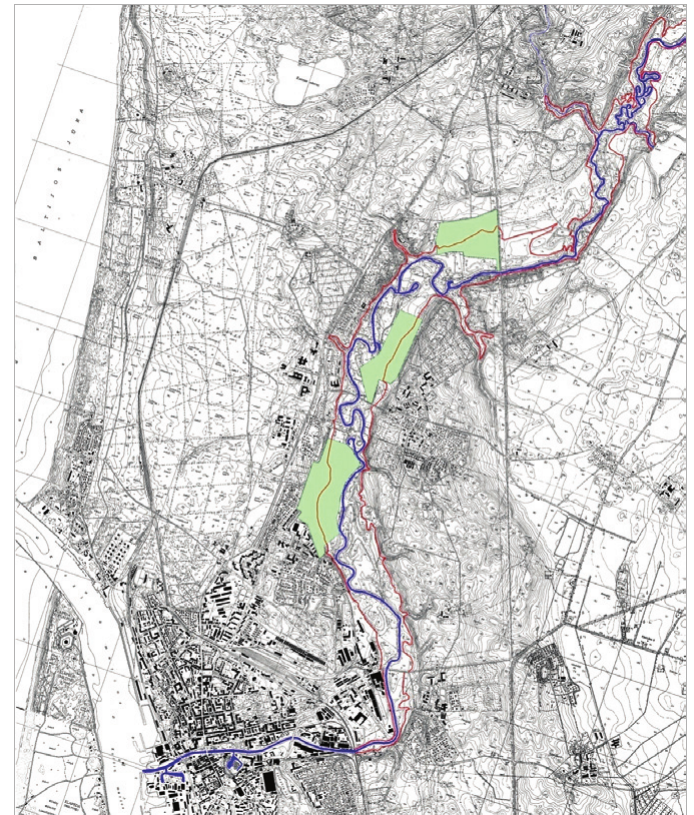
Fig. 6. Modeled flooded territories by the Akmena-Danė river within the City of Klaipėda and its suburbs (10–12 August, 2005) under the combined impact of stormy runoff and marine water surge. Red line shows maximum flood extent but flooded residential and recreational areas are shadowed by